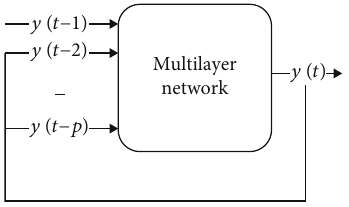
Figure 1: Architecture of the nonlinear autoregressive neural